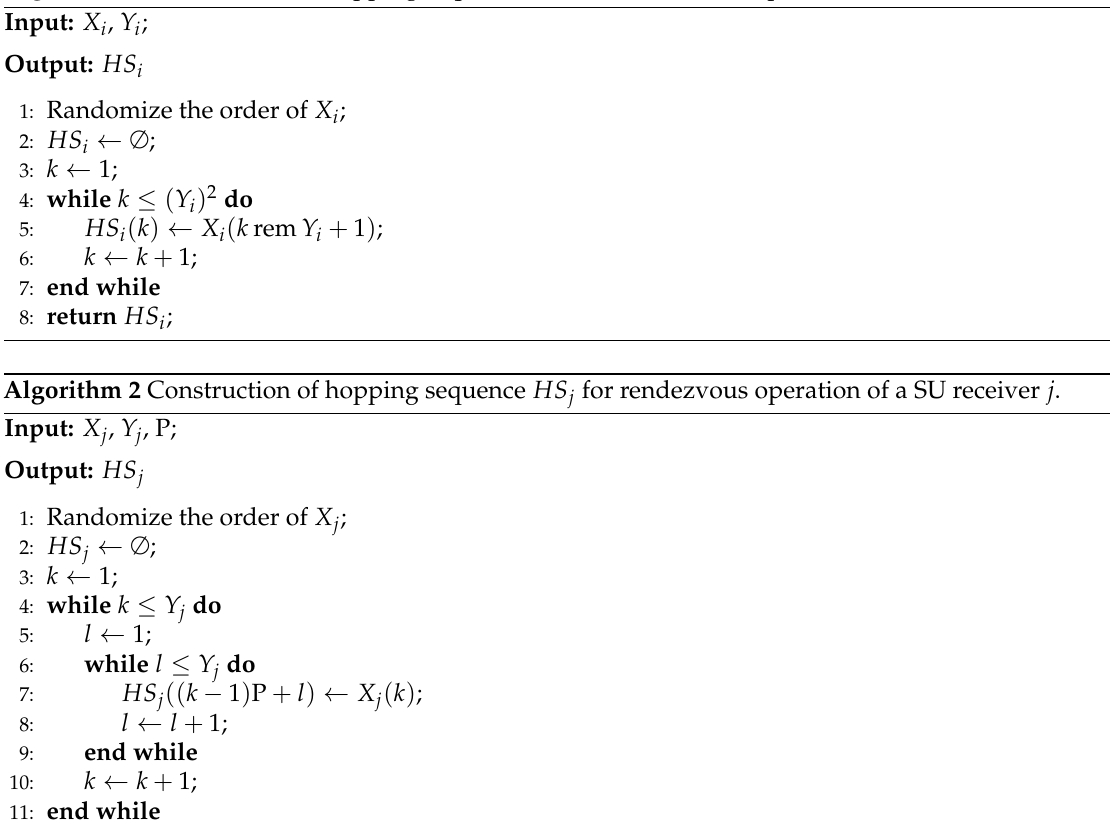
Algorithm 1 Construction of hopping sequence HS i for rendezvous operation of a SU transmitter i .